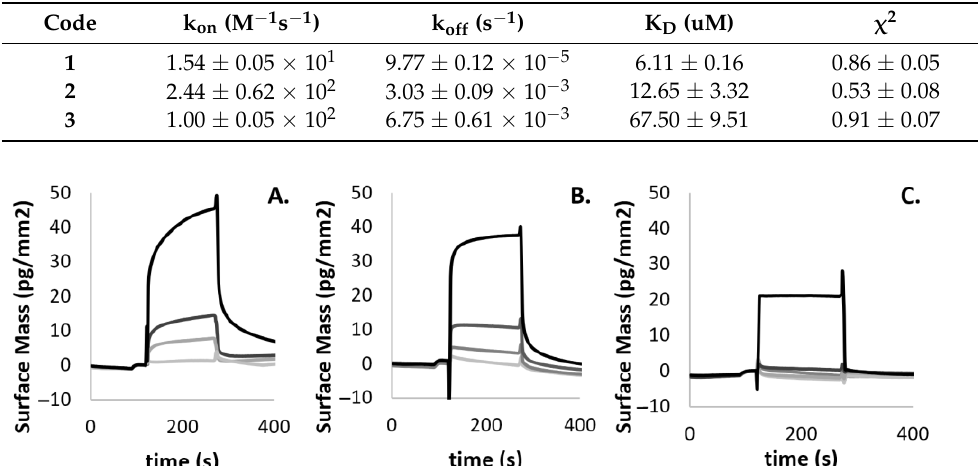
Table 2. Kinetic and quality parameters determined by GCI for the interaction of compounds 1 – 3 with Mab -SaS.